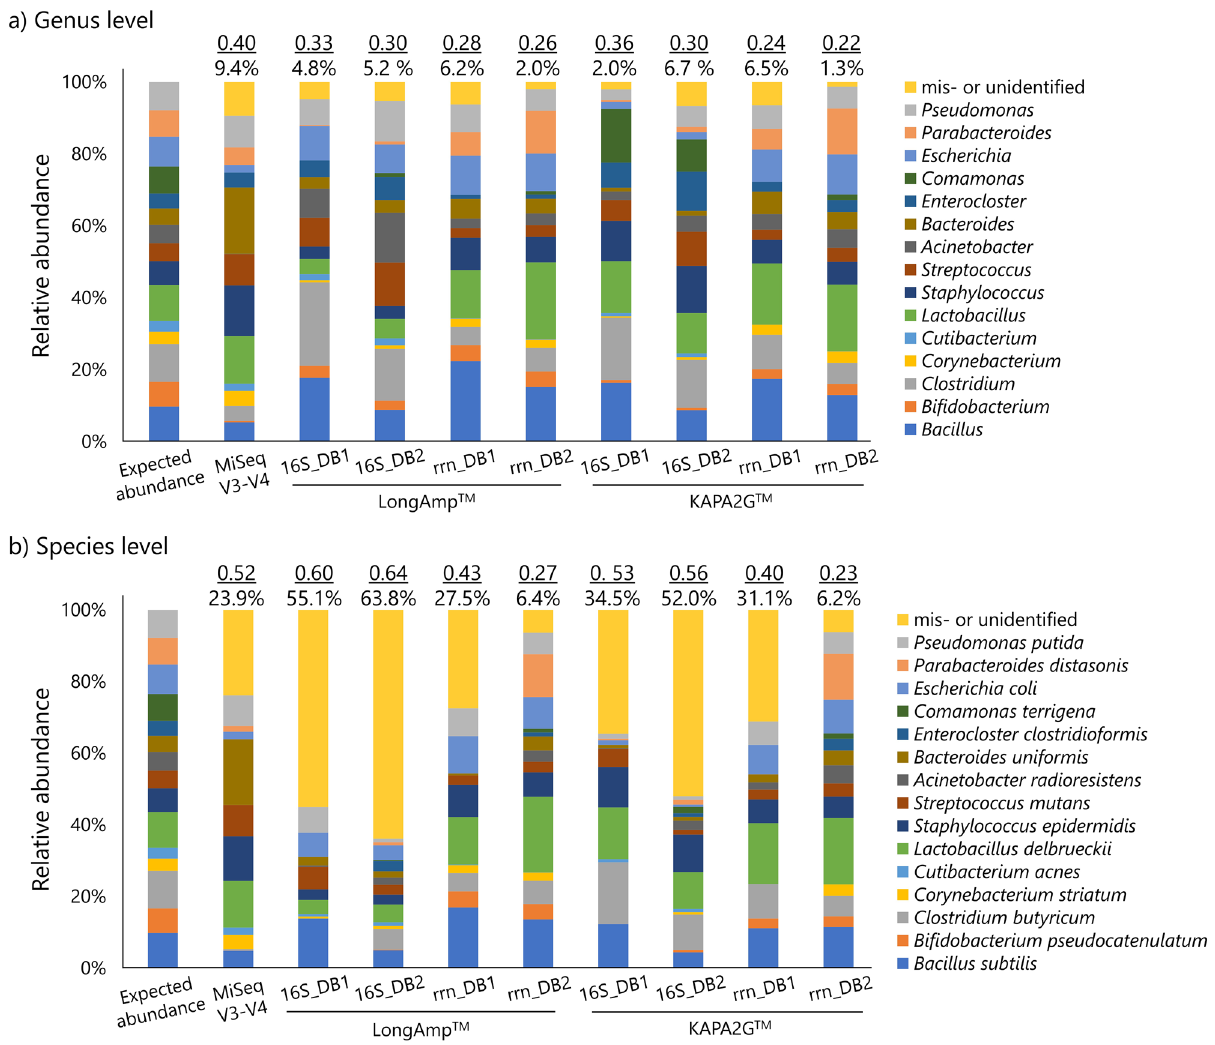
Figure 1. Relative abundance of mock community at ( a ) genus and ( b ) species levels. Indices of dissimilarities between the expected abundance and each sequencing condition (underlined) and the percentages of mis- or unidentified sequences are shown above each bar graph. 16S full-length 16S rRNA gene amplicon sequencing, rrn rRNA operon amplicon sequencing. DB1: rrn DB 24 . DB2: ncbi_202006